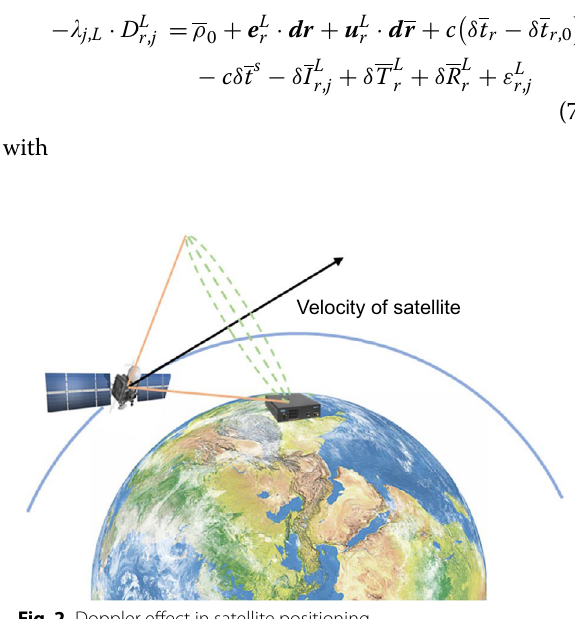
Fig. 2 Doppler effect in satellite